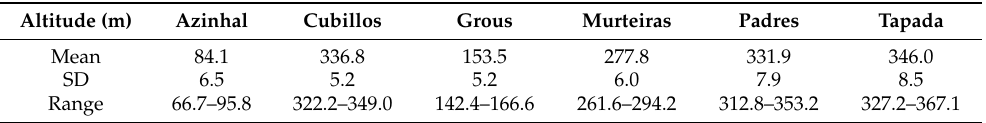
Table 3. Descriptive statistics (mean, standard deviation and range) of the altitude in each of the six experimental fields used in this work.